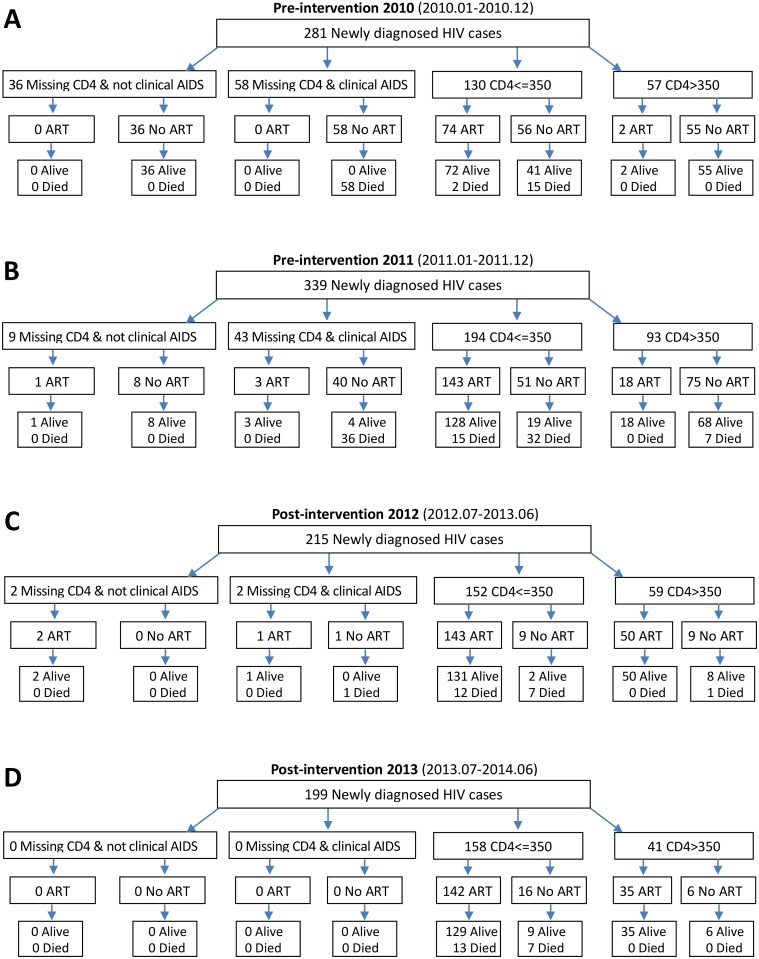
Number of HIV diagnoses, ART initiations, and deaths in the pre-intervention 2010, pre-intervention 2011, post-intervention 2012, and post-intervention 2013 phases in Guangxi, China.